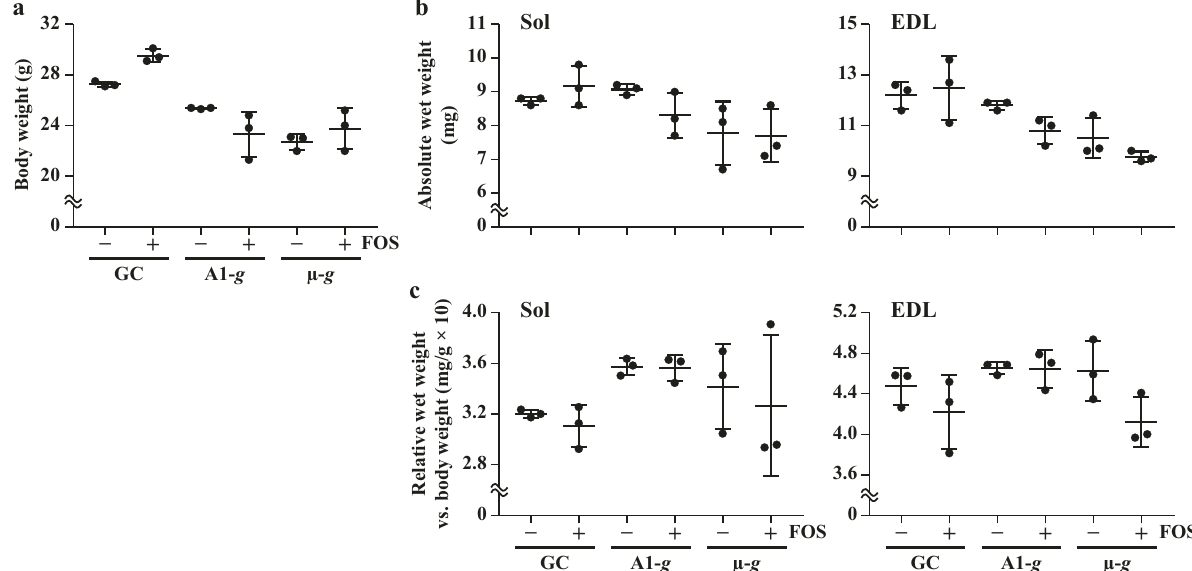
Fig. 1 Effects of space fl ight on body weight and wet weight of skeletal muscles of mice, fed a diet with or without fructo-oligosaccharide (FOS). The data are presented as the mean ± standard deviation ( n = 3). The data pertaining to body weight, absolute wet weight of soleus (Sol) and extensor digitorum longus (EDL) muscles, and the wet weight of Sol and EDL muscles relative to body weight are depicted in panels ( a − c ), respectively. Ground control (GC): group of mice raised in the ground model of the Multiple Arti fi cial-gravity Research System habitat and transportation cage units; arti fi cial 1- g (A1- g ): group of mice raised under arti fi cial 1- g on the International Space Station (ISS); microgravity ( μ - g ): group of mice raised under μ - g on the ISS; and FOS ( + ) or ( − ): groups of mice fed a diet with or without FOS,